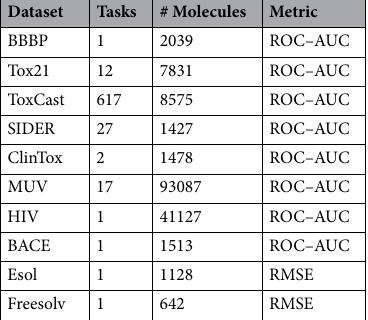
Table 1. Information of dataset from